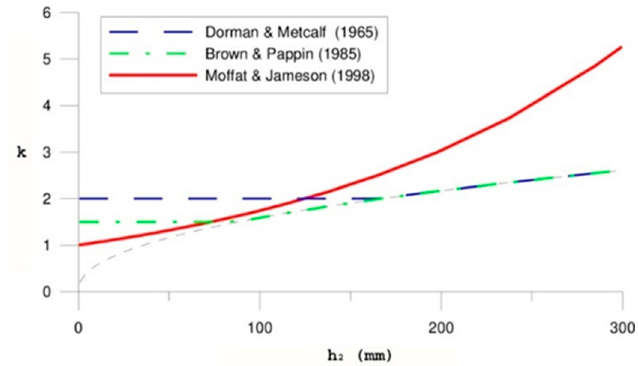
Figure 4. Comparison of k from alternative correlations [46], namely Dorman and Metcalf [42], Brown and Pappin [43] and Moffat and Jameson [45].